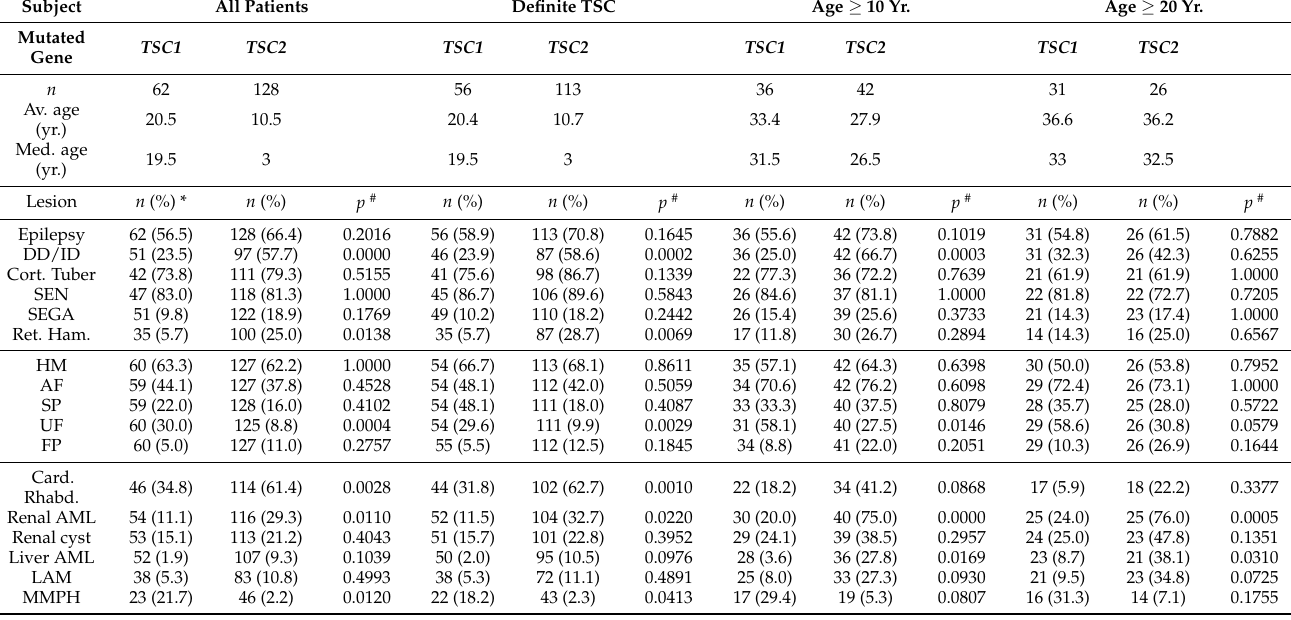
Table 6. Difference in each symptom and lesion between TSC1 and TSC2 patients.